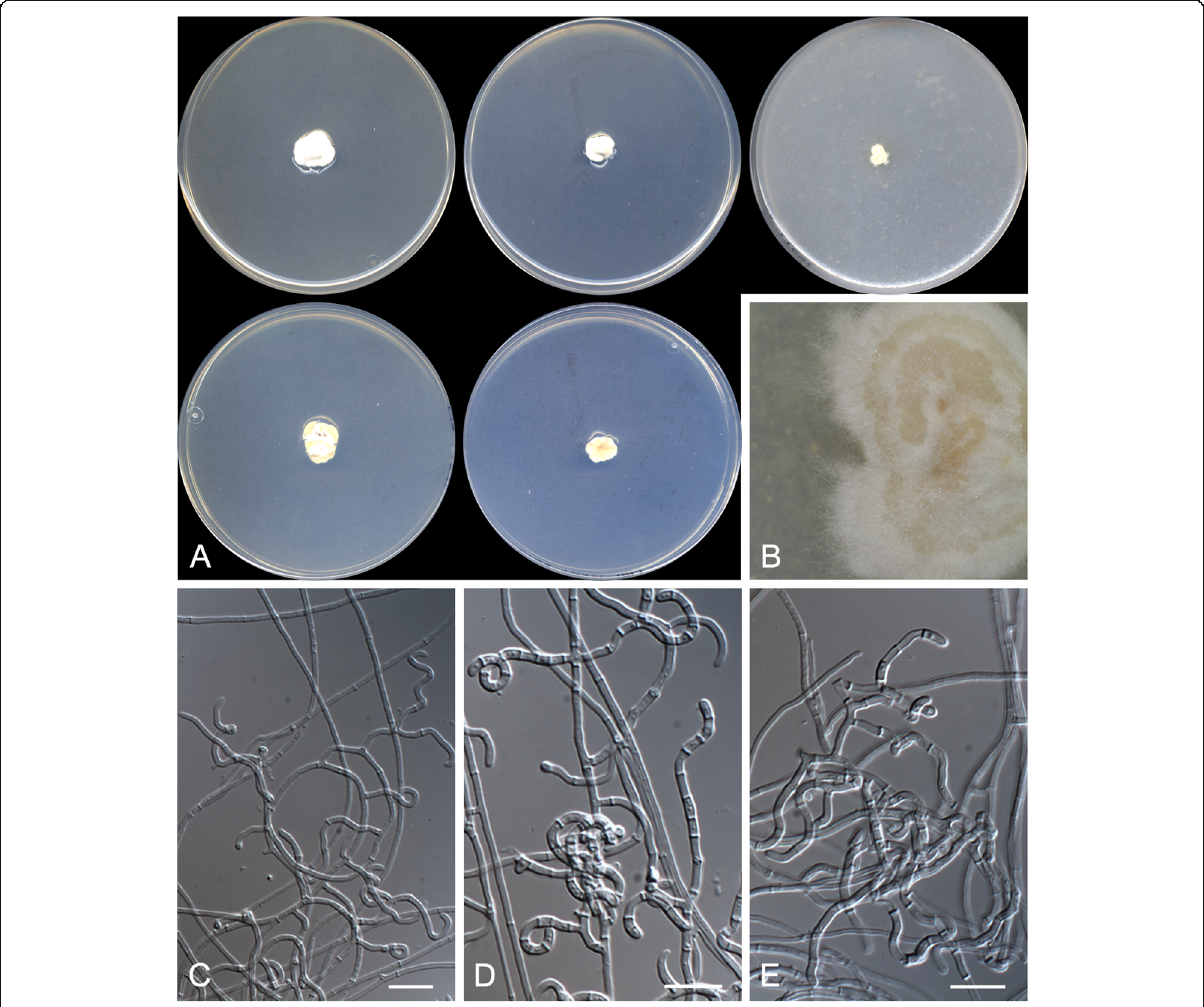
Fig. 4 Arachnomyces graciliformis CBS 146927 T . a Colonies on PYE, PDA and OA after 14 d at 25 °C, from left to right (top row, surface; bottom row, reverse). b Detail of the colony on OA. c – e Contorted, apically coiled fertile hyphae bearing arthroconidia. Scale bar = 10 μ